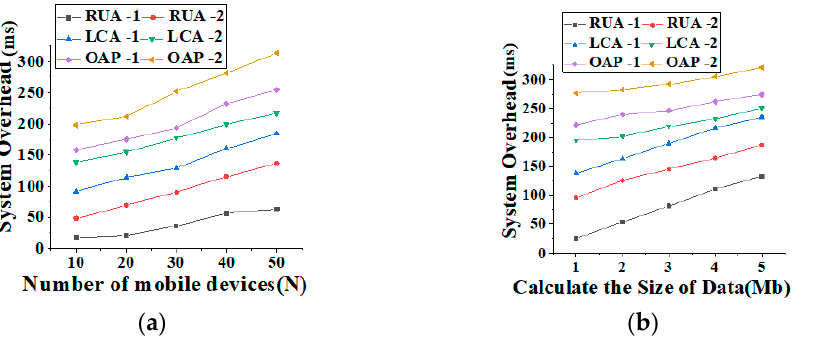
Figure 7. Variation curves of the influence of the mobile device number and the data volume on the system overhead: ( a ) mobile device number on the system overhead; ( b ) data volume on system overhead.